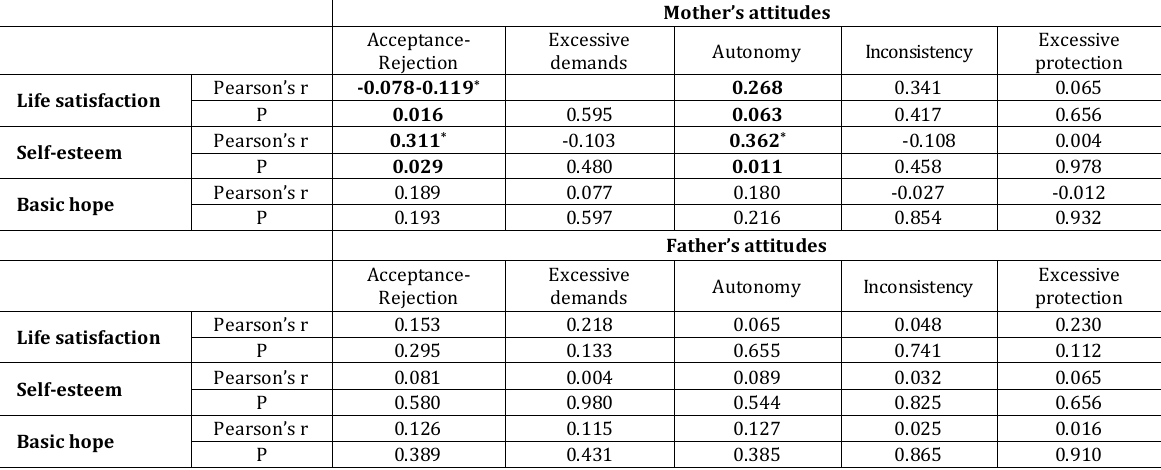
Table 1. Significance, strength and direction of the relationship between parental attitudes and life satisfaction, self- esteem and basic hope in adults with the ACoA syndrome